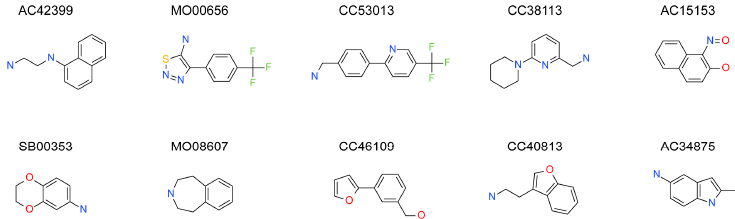
Figure 4. Top 10 fragment binders against hAQP1 discovered using SPR screening.